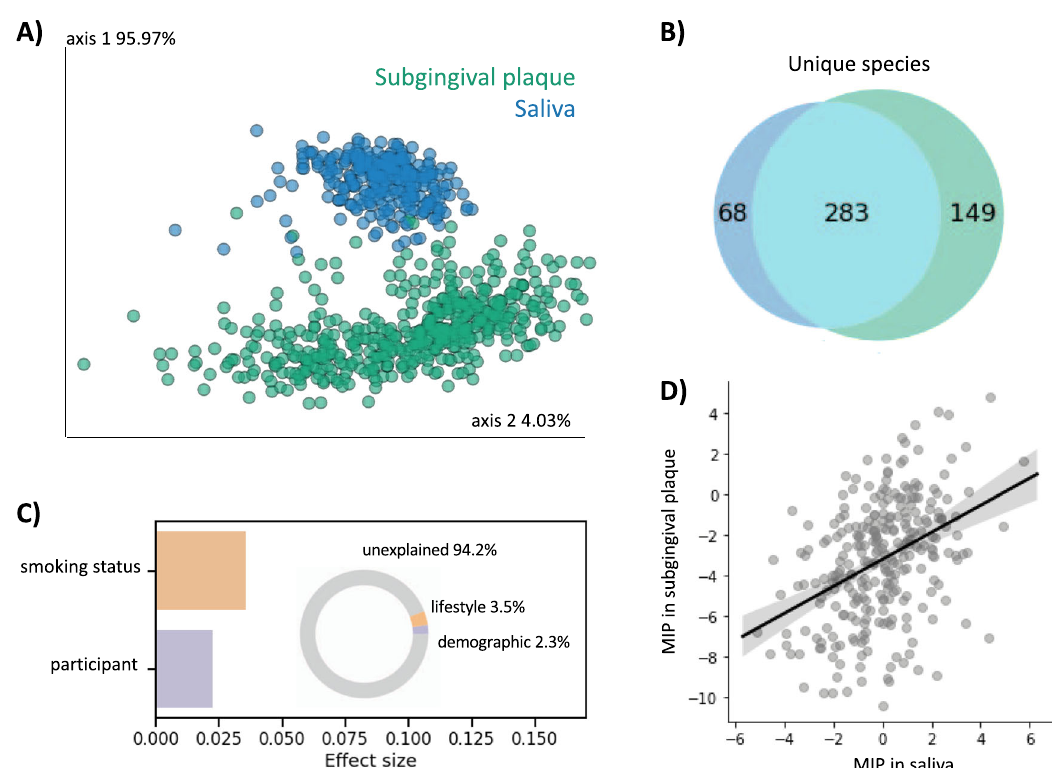
Fig. 4 Plaque and saliva are compositionally distinct but have correlated MIP. A Beta-diversity analysis with RPCA shows distinct clustering of saliva vs. subgingival plaque samples (PERMANOVA < 0.001). B Venn diagram of 16 S rRNA gene amplicon sequencing data collapsed to the species level shows a majority of microbial species were identi fi ed in both saliva and subgingival plaque, and that subgingival plaque was more diverse. C Redundancy analysis (RDA) estimates the percent microbial diversity explained by each variable. Inset donut chart sums effect sizes by category; unlike subgingival plaque, saliva microbial diversity is driven by lifestyle or demographic variables and is not signi fi cantly explained by metabolic or periodontal measures. D Microbial indicator of periodontal disease (MIP) was signi fi cantly correlated between subgingival plaque and saliva samples, despite having been processed at different institutes with different sequencing parameters and being related to different variables (Pearson R = 0.387, p -value =